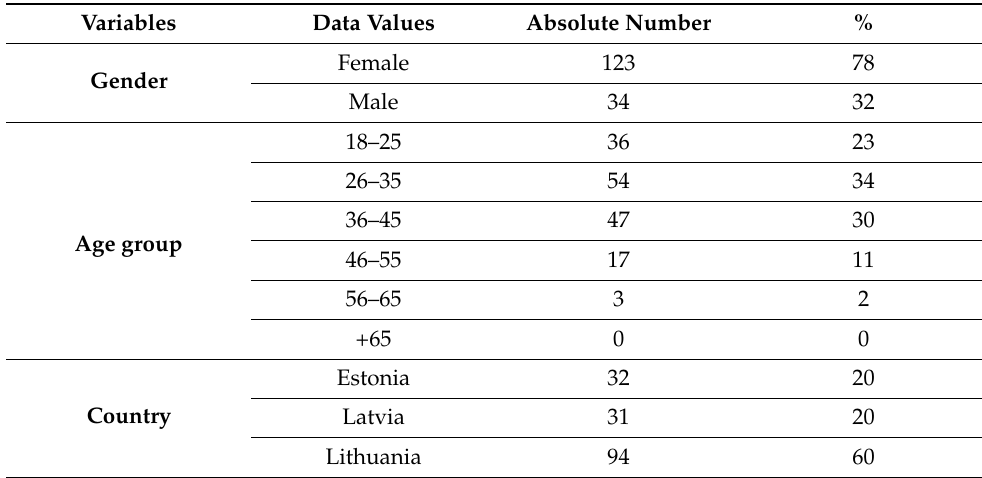
Table 3. Characteristics of the research sample. Source: composed by the authors .